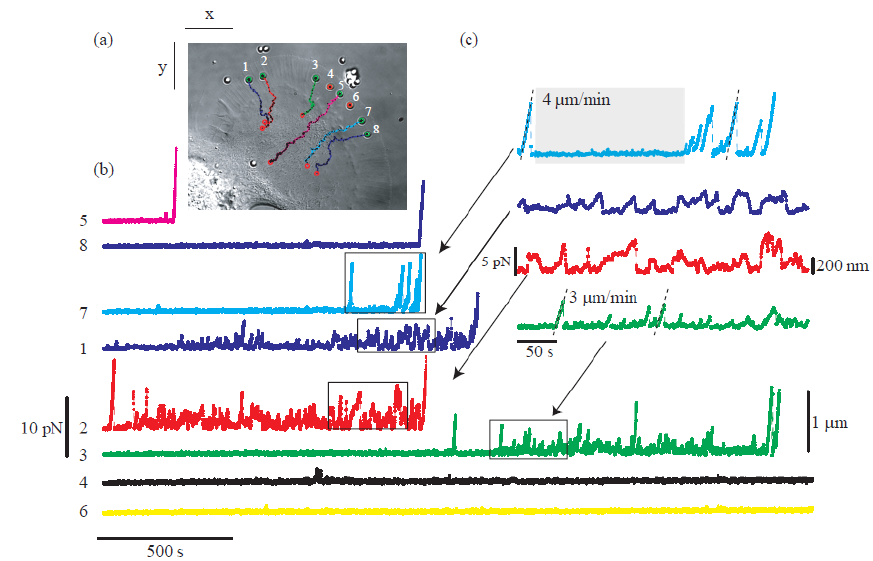
Figure 10. Growth cone study of base on multiple force measurement [124] . ( a ) HOT hold the position of beads near the leading edge of the growth cone. ( b , c ) The force measured when the cell pulls the bead.